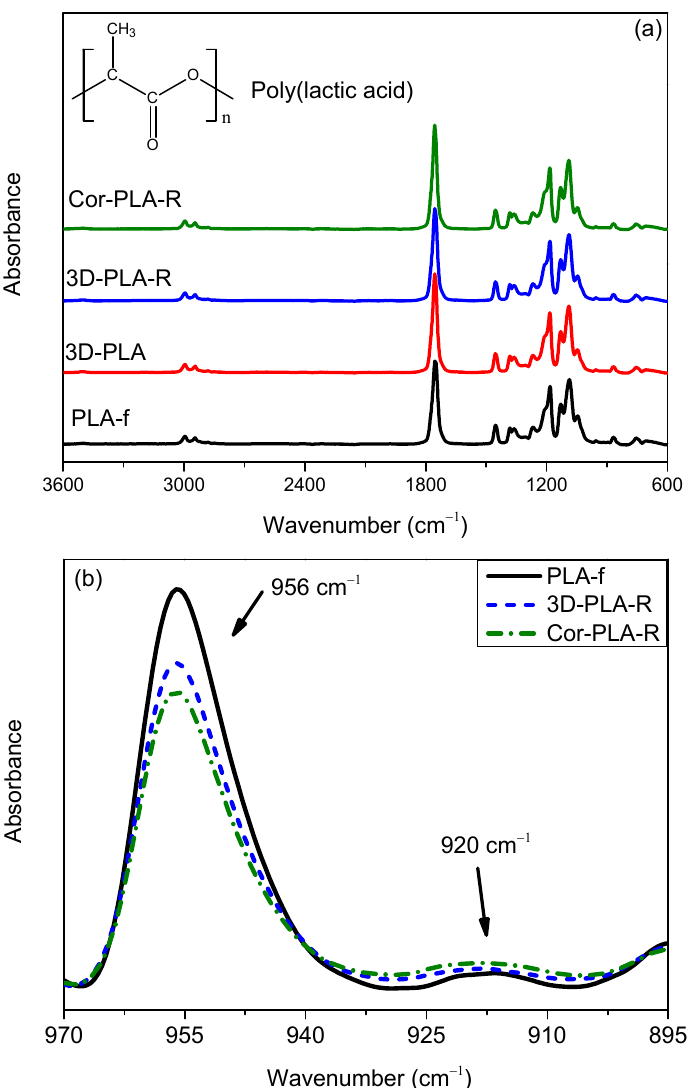
Figure 2. FTIR-ATR normalized spectra of the samples before and after recycling between Figure 2. FTIR ‐ ATR normalized spectra of the samples before and after recycling between 3600–600 cm − 1 ( a ) and 970–895 cm − 1 ( b ). Table 2. FTIR ‐ ATR bands assignation.